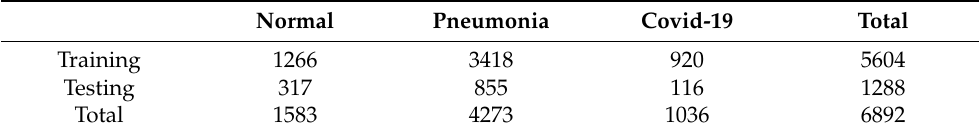
Table 2. The construction of the Chest-1